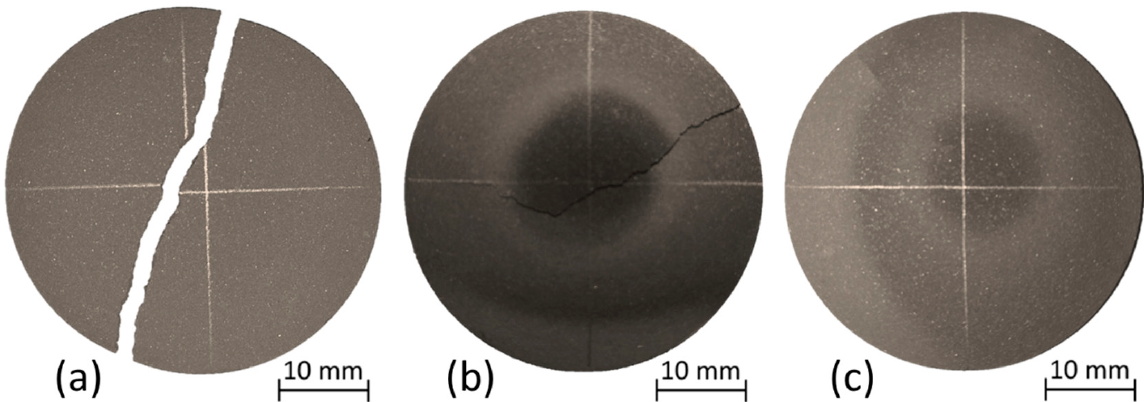
Figure 6. The three outcomes of the performed thermal stress failure tests: complete failure ( a ), incomplete crack propagation ( b ), and no evident cracking ( c ).